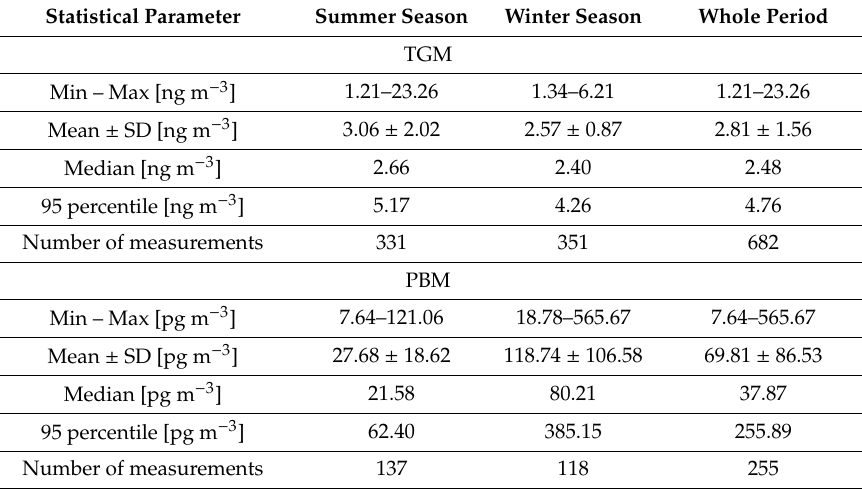
Table 1. Descriptive statistics of the measurement results (24 h concentrations) of total gaseous mercury (TGM) and PM 2.5 -bound mercury (PBM) at the urban background station in Zabrze, 2014–2015.